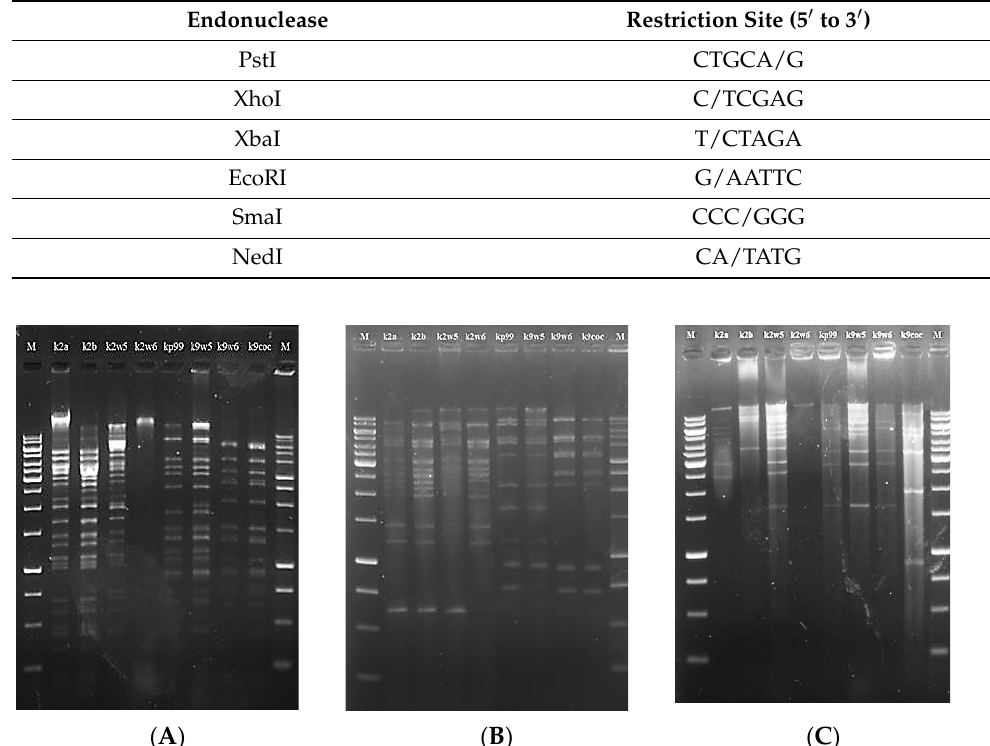
Figure 5. Restriction digestion analysis of the eight bacteriophages DNA. M:1 kb DNA marker, image ( A ) pstI, ( B ) smaI, ( C ) NdeI. Table 4. Endonucleases used for the restriction analysis of phage DNA.